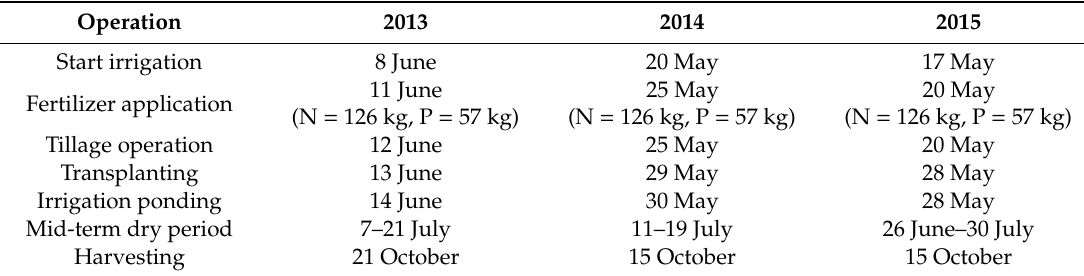
Table 1. Farming activities at the experimental paddy